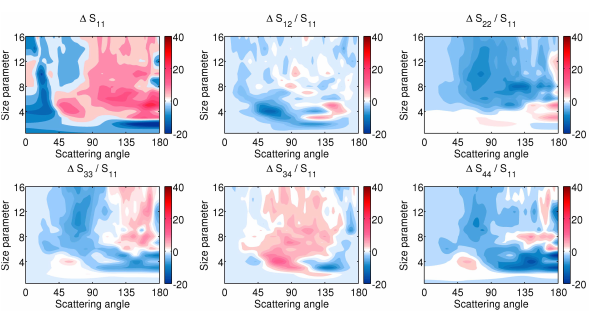
Fig. 8. Size dependence of the differences in the scattering-matrix elements between the inhomogeneous and homogeneous stere- ogrammetric shapes of Agg I.